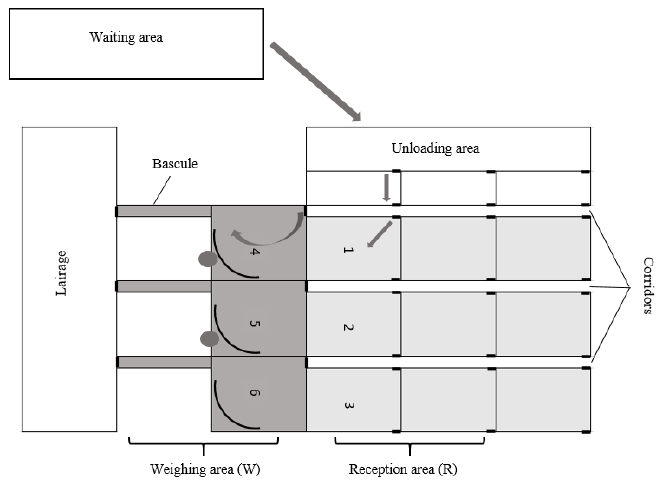
Figure 1. Schematic representation of observed sections of the driving areas from the corridors to the reception area (light grey and white), and from the reception area to the weighing area (dark grey).